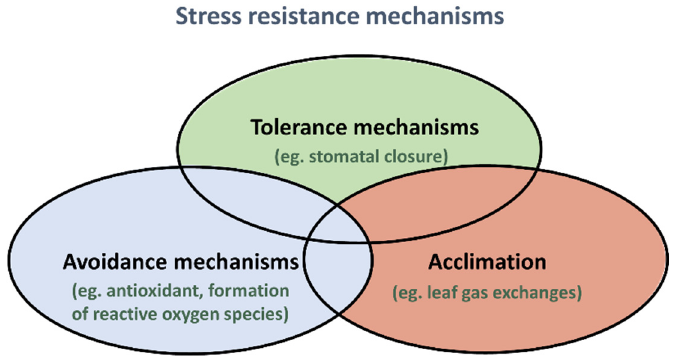
Figure 2. Conceptual framework of abiotic stress resistance mechanism in a tree.